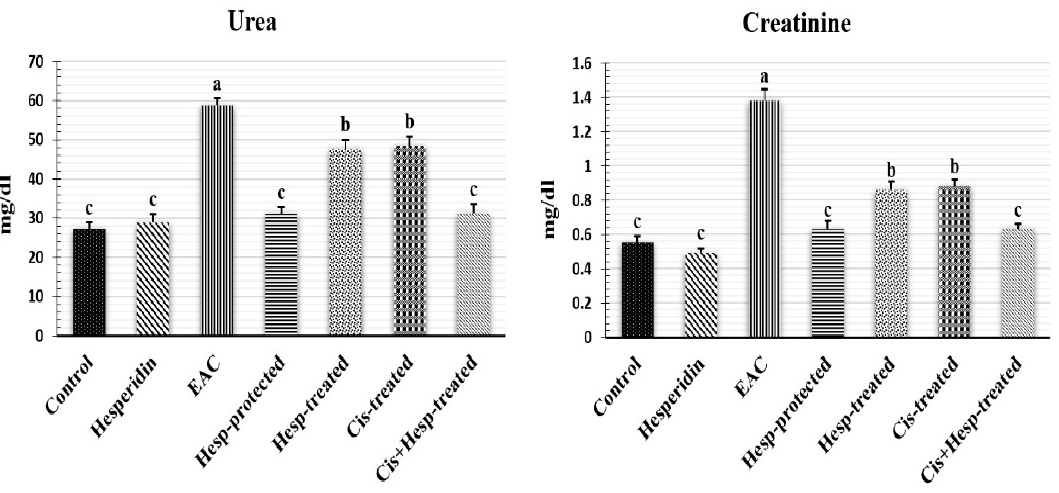
Figure 1. Effect of hesperidin and/or cisplatin on serum urea and creatinine levels of EAC-bearing mice ( n = 7). Different letters (a, b, c) indicate significant differences at p < 0.05. EAC: Ehrlich ascites carcinoma; Hesp: hesperidin; Cis: cisplatin.